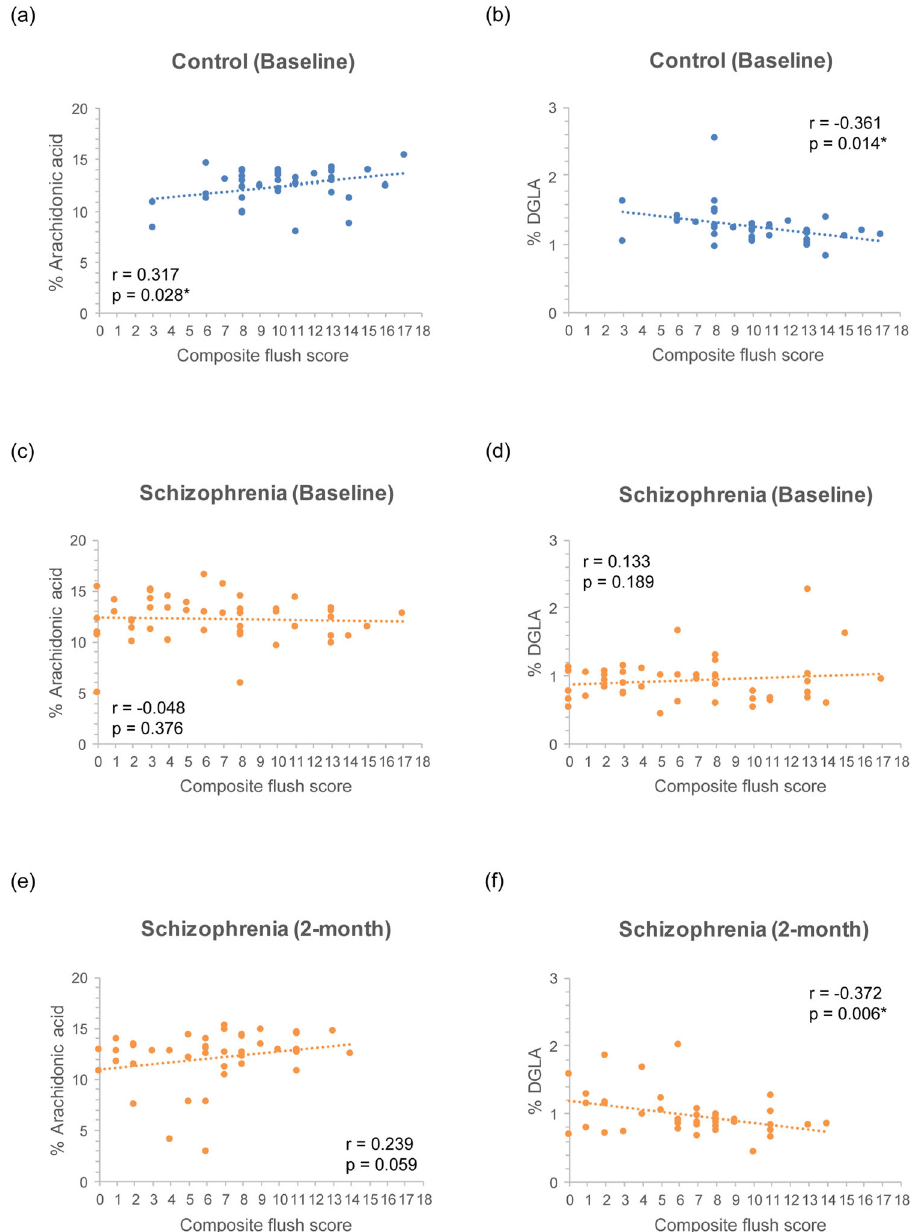
Fig. 2 PUFAs and the niacin fl ush response. Pearson correlations between the composite fl ush score of the niacin skin test and the level of arachidonic acid and dihomo-gamma-linolenic acid (DGLA) for healthy controls ( n = 37) at baseline ( a , b ) as well as schizophrenia patients ( n = 46) at baseline ( c , d ) and at a 2-month follow-up ( e , f